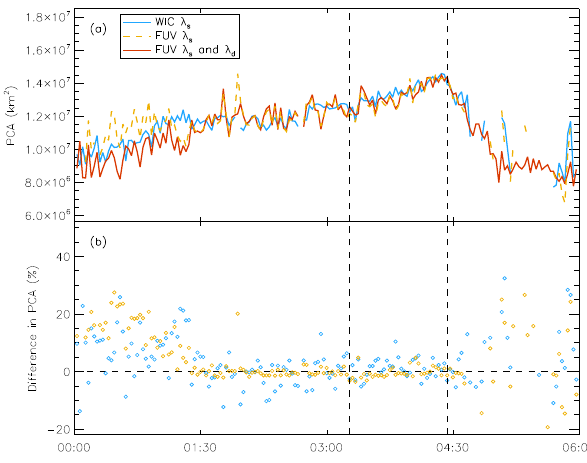
Fig. 11. Polar cap areas estimated from IMAGE FUV auroral boundaries on the 1 February 2001 between 00:00 and 06:00UT. Panel (a) shows the PCA estimates derived from auroral boundaries obtained using the method outlined in this paper. The areas are cal- culated from boundaries estimated from single and double Gaussian fits to intensity profiles from the best combination of all three IM- AGE FUV cameras (solid red line), from boundaries obtained from single Gaussian fits to intensity profiles from the best combination of all three cameras (dashed yellow line), and from boundaries ob- tained from single Gaussian fits to intensity profiles from the WIC camera only (solid blue line). Correction offset values have been applied to these auroral boundaries. Panel (b) shows the relative difference in PCA estimated from boundaries from single Gaussian fits from all three FUV cameras (yellow diamonds), and boundaries from single Gaussian fits from the WIC camera (blue diamonds) with respect to area estimates from boundaries derived from both single and double Gaussian fits to intensity profiles from all three FUV cameras. Vertical dashed black lines indicate times of sub- storm onset from the list outlined in Frey et al.